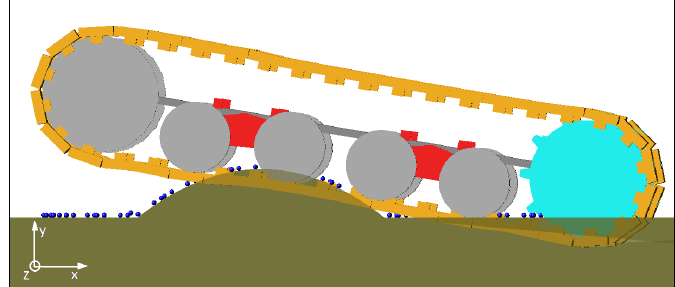
Figure 9. Auxiliary spheres following the undeformed shape of the terrain